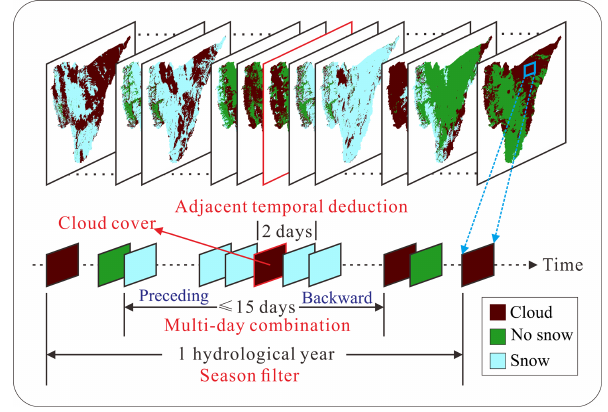
Figure 2. Temporal filters for the MODIS SCA